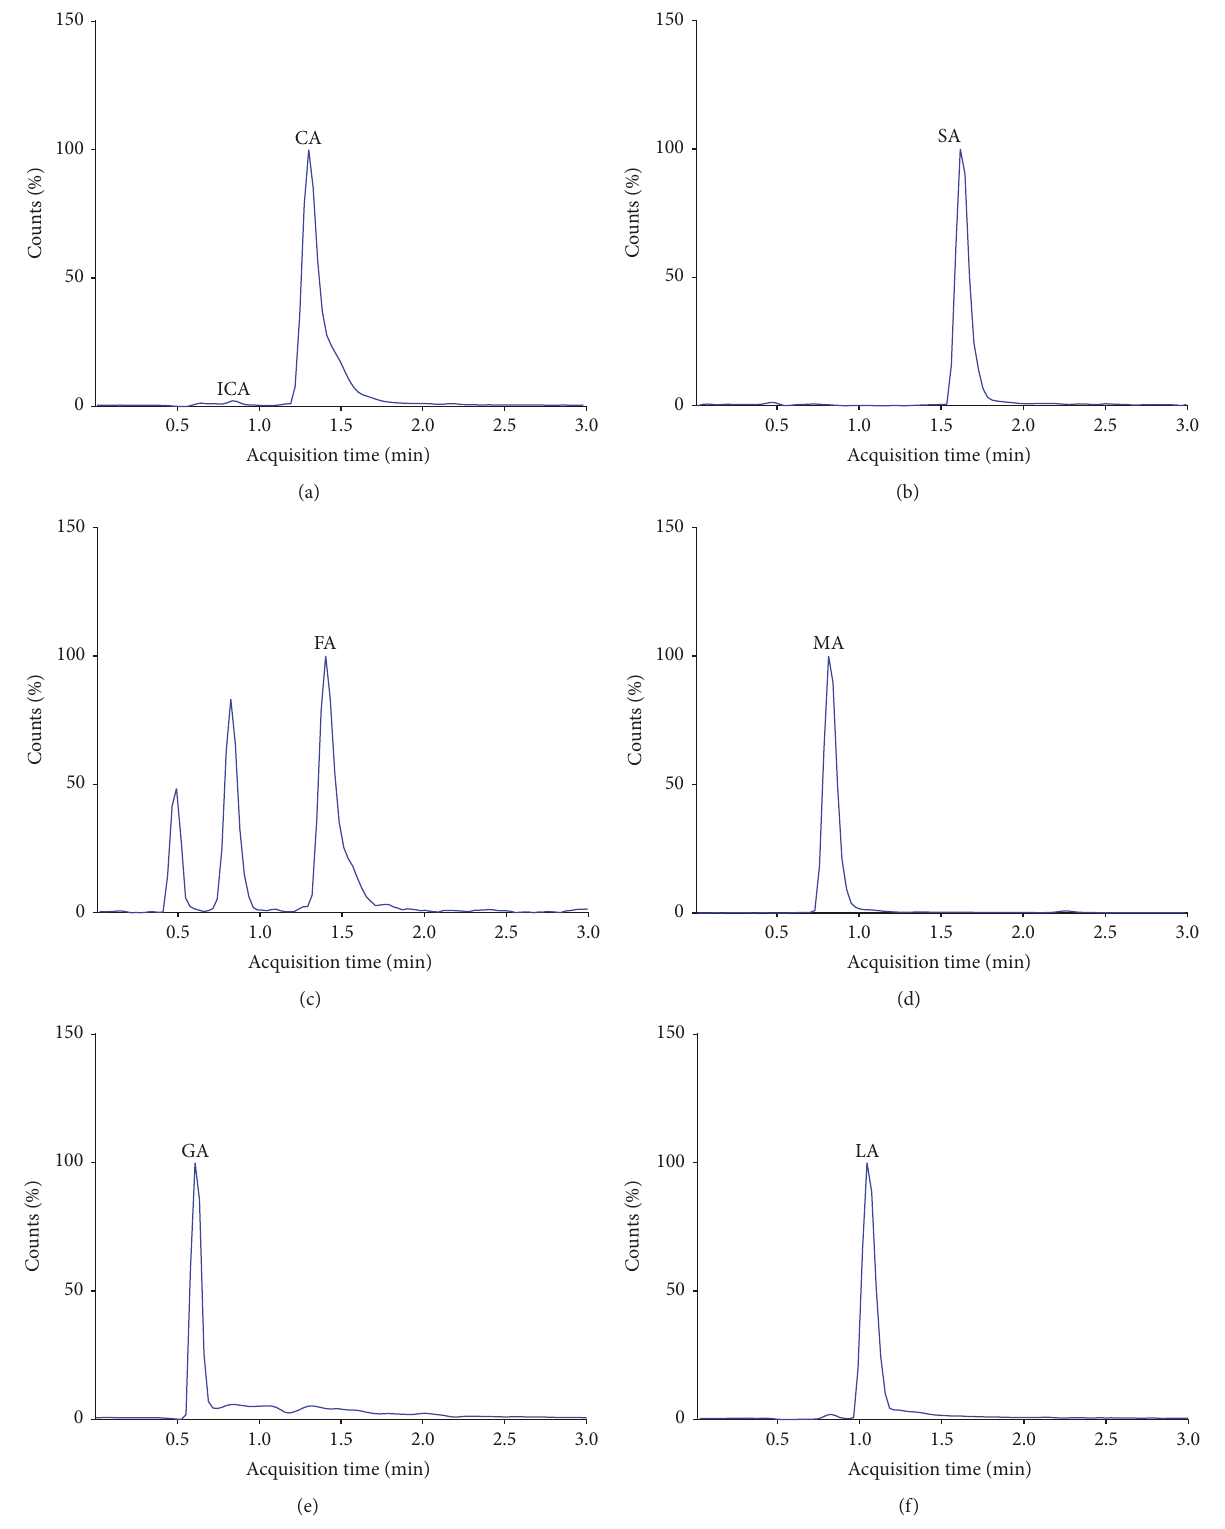
Figure 5: LC-MS/MS chromatograms of TCA cycle intermediates extracted from human cultured PC3 cells. (a) Citric (CA) and isocitric (ICA) acids; (b) succinic acid (SA); (c) fumaric acid (FA); (d) malic acid (MA); (e) glutamic acid (GA); (f) lactic acid